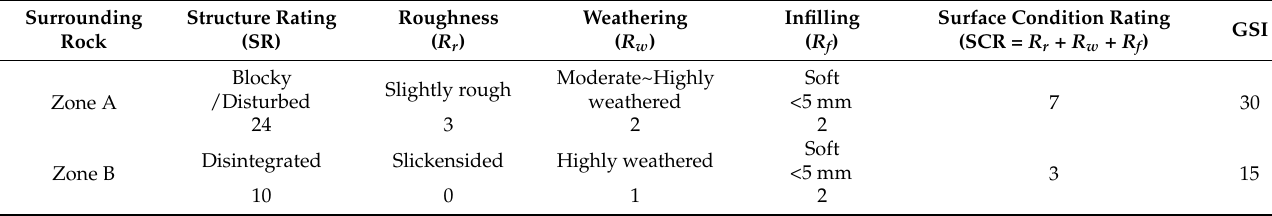
Table 1. Determination of GSI.